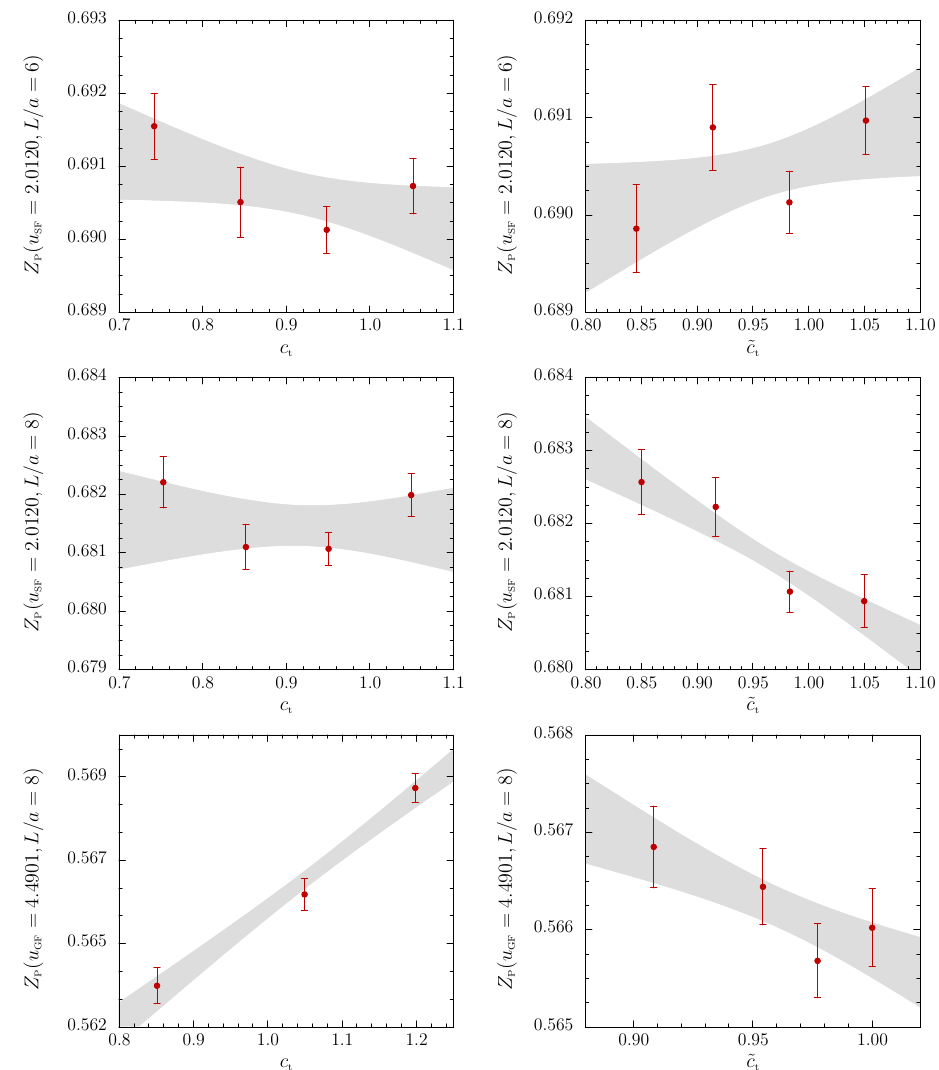
c t and ˜ c t . The shadowed bands are linear fits to the